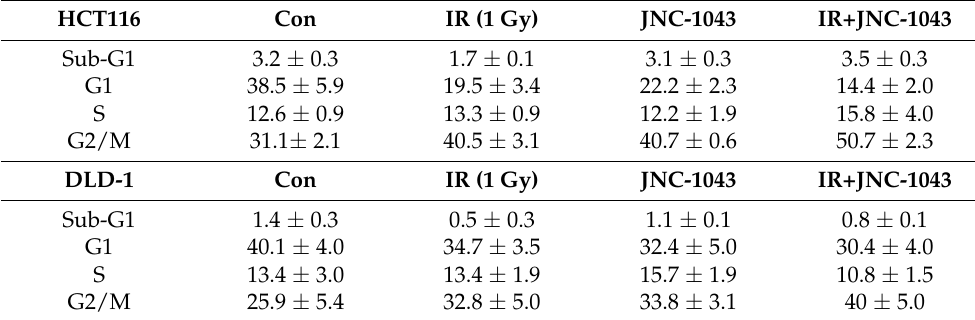
110 nM or 150 nM JNC-1043. ( b ) Immunoblot assay for detection of cyclin B1, p21, and β -actin. HCT116 and DLD-1 cells (8 × 10 5 ) were treated with or without 110 or 150 nM JNC-1043, respectively, exposed to 1 Gy IR, and incubated for 2 or 4 h, respectively, prior to harvest. Each graph in the right panel presents the statistical analysis of the immunoblot bands. The relative band densities were analyzed as described in the Materials and Methods. All experiments were repeated in triplicate, and the bands in the figures show representative data. * p < 0.05, ** p < 0.01, *** p < 0.001. Table 3. Effect of JNC43 and irradiation on the cell cycle distribution of CRC cells. HCT116 Con IR (1